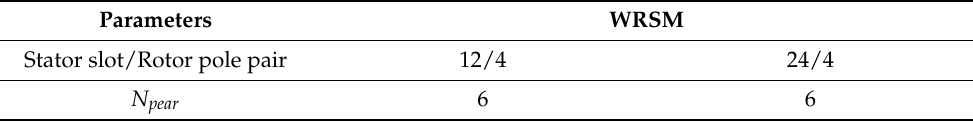
Table 3. Predicted N pear for the Analyzed WRSMs.